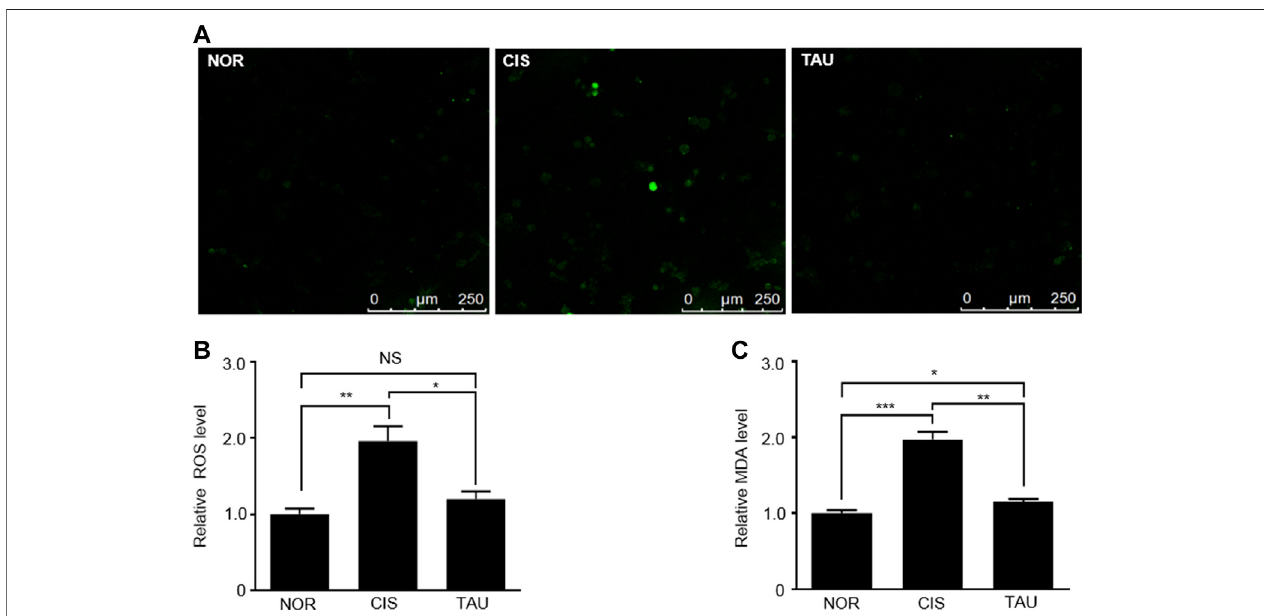
FIGURE 1 | Taurine supplementation promoted the clearance of cisplatin-induced ROS in C2C12 myoblasts. (A) Representative confocal microscopy image of H 2 DCFDA-stained normal control (NOR) myoblasts, cisplatin-treated (CIS) myoblasts, and taurine-supplemented (TAU) myoblasts. Scale bar, 50 µm. (B) Intracellular ROSlevelsdeterminedbyoxidizedH